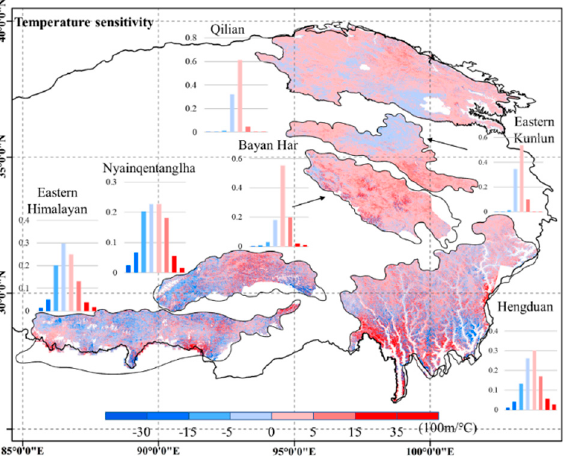
Figure 9. The spatial distribution of the sensitivity of the elevational movement of NDVI isoline to air temperature in the six mountainous regions. In each mountainous region, the histogram was inserted showing the proportion of pixels in each interval of the legend.